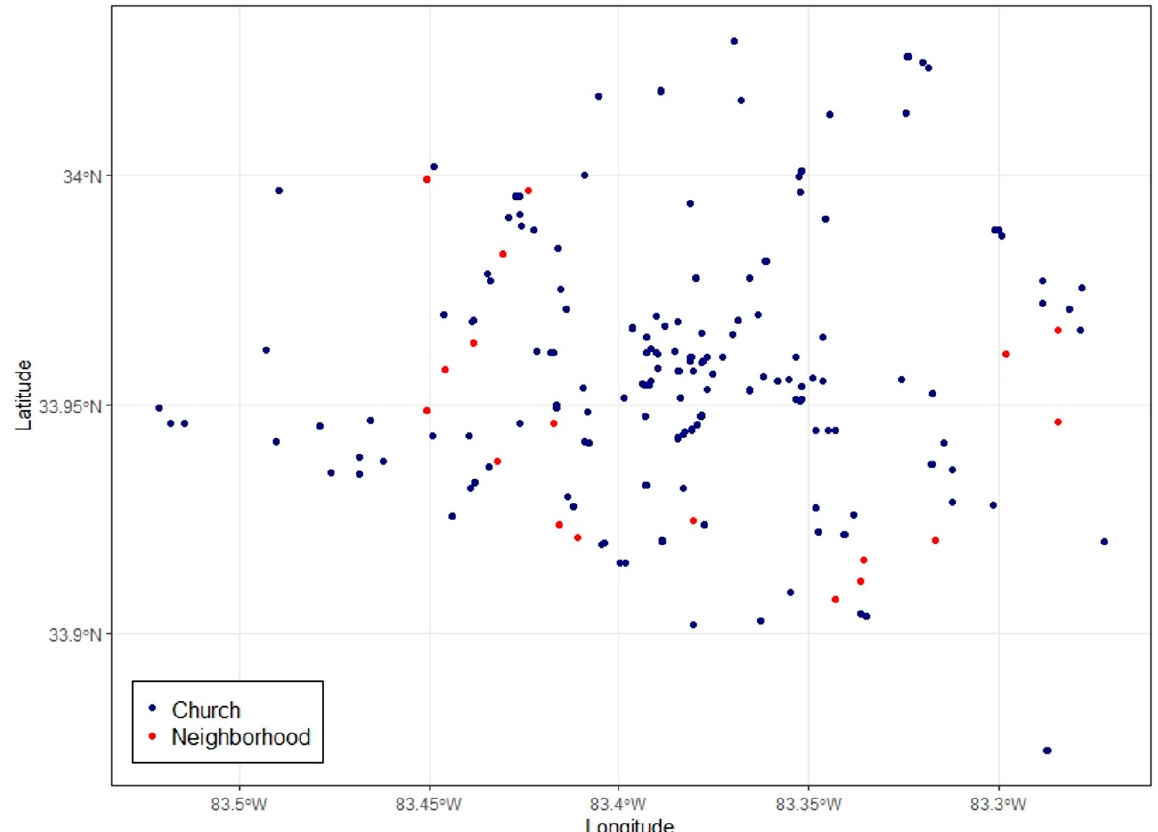
Figure 8. Distribution of Church and Neighborhood locations in Athens, GA.